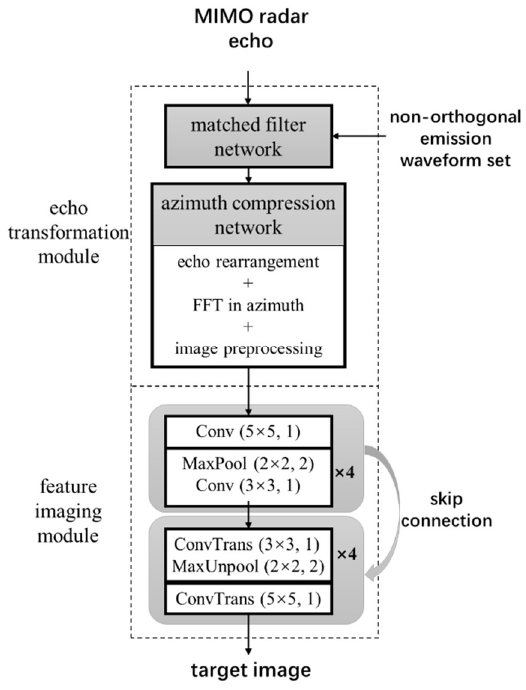
Figure 2. Network structure of MIMO-LI-Net.